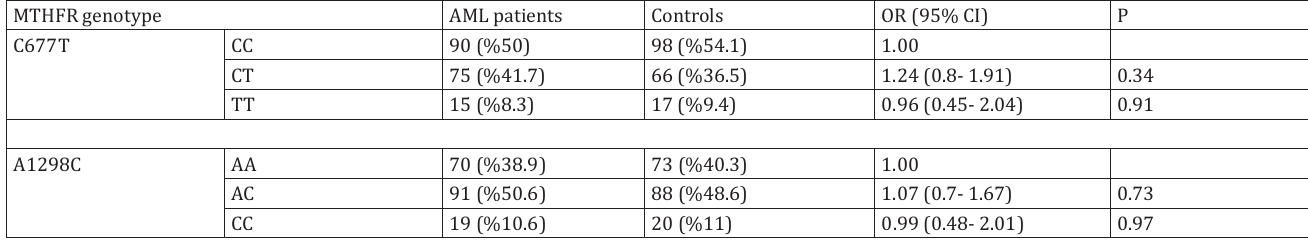
Distribution of MTHFR polymorphisms in AML MTHFR